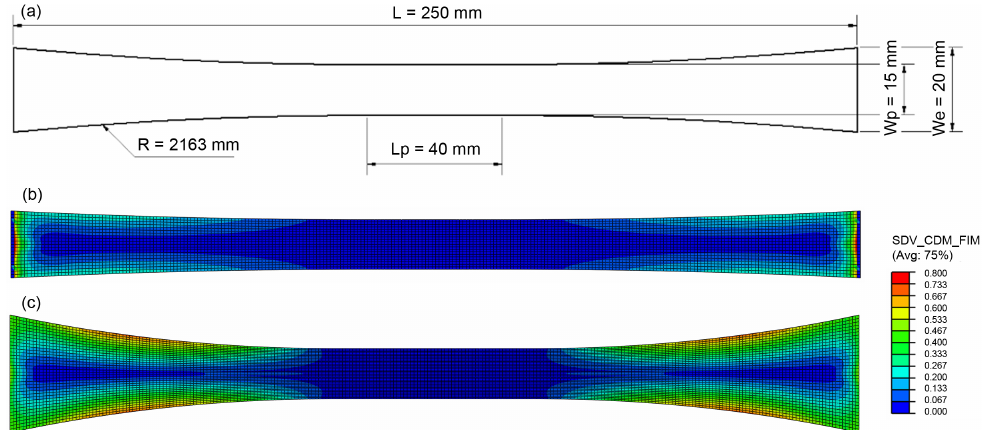
Figure 2. Schematic presentation of the final dogbone geometry ( a ). W e , W p and L p were varied during the FEA investigation, as shown in ( b , c